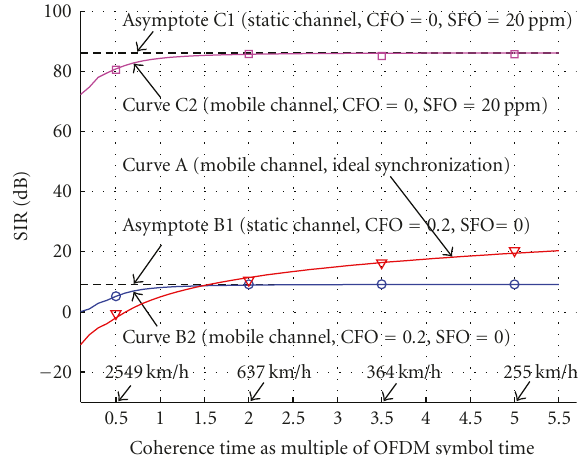
Figure 2: Individual contributions of mobility (curve A), carrier frequency o ff set (CFO, curves B1 and B2), and sampling frequency o ff set (SFO, curves C1 and C2) to the SIR. Solid curves are evaluations of (23) and markers represent simulation results. System parameters are as in Figure 1.